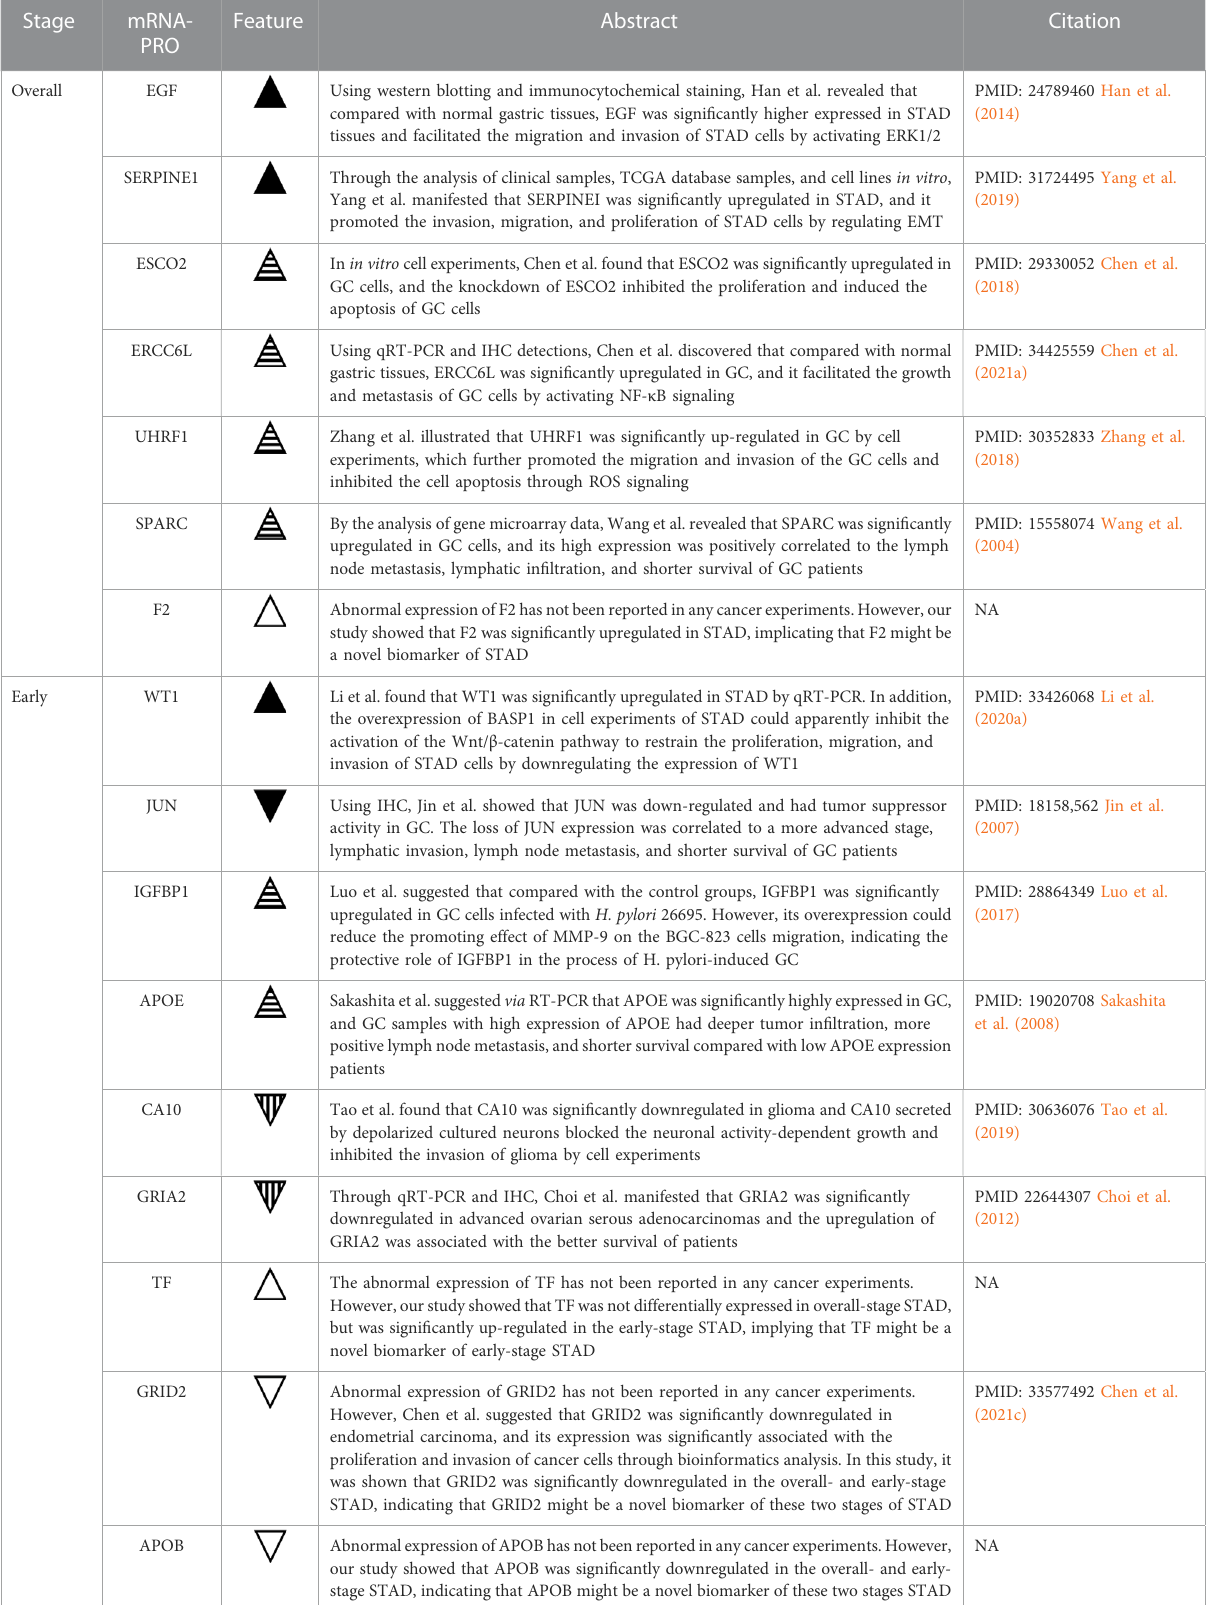
TABLE 1 Comparison of the abnormal expressions of the mRNAs-PRO in the overall-, early-, and progressive-stage STAD between this study and previous experimental studies.